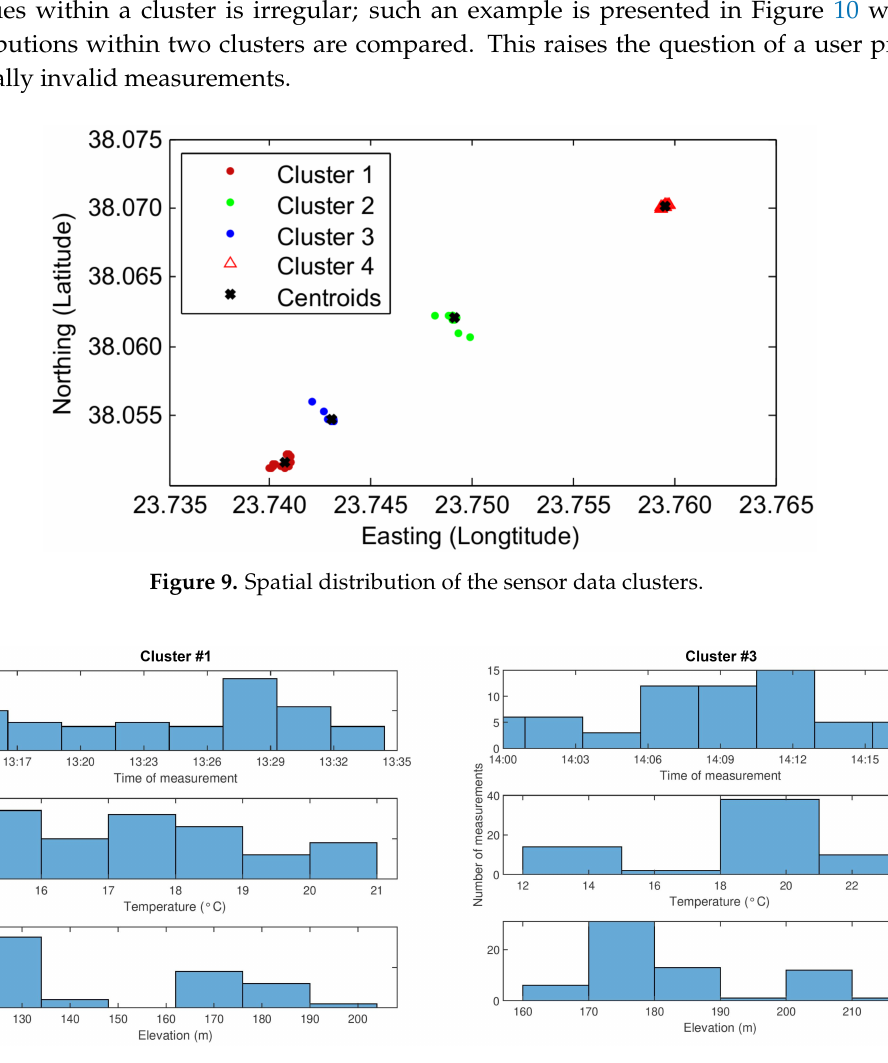
Figure 10. Normal vs irregular intra-cluster data distribution.